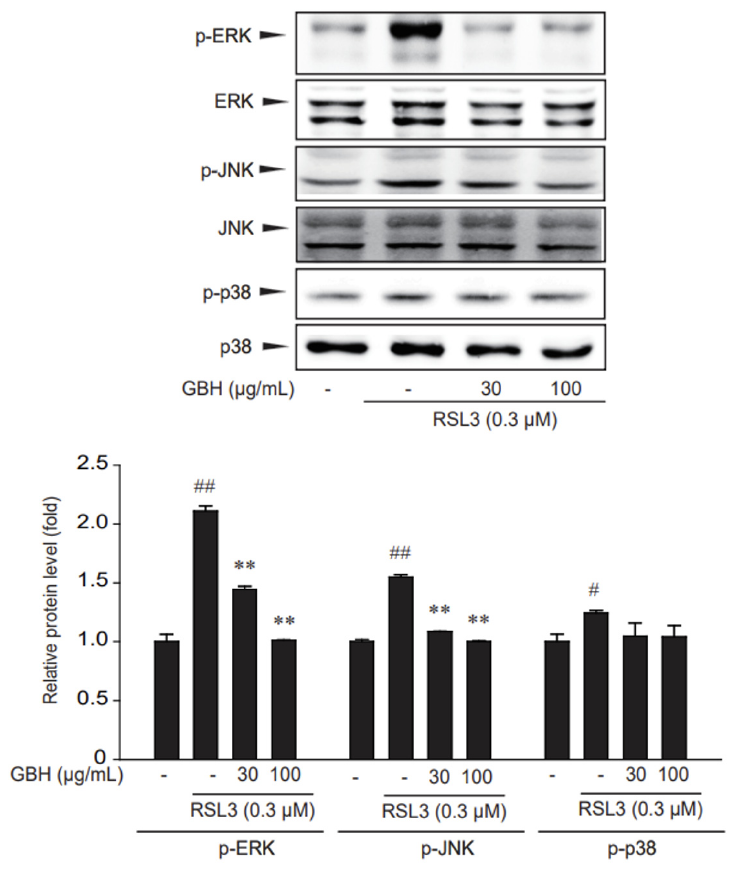
Figure 5. Inhibition of ERK and JNK phosphorylation by GBH in RSL3-induced HT22 cells. Im- munoblotting for MAPKs phosphorylation. Cells were treated with 30 or 100 µg/mL GBH 1 h before being incubated with RSL3 for 1 h. The cell lysates were immunoblotted. Data represent the mean ± S.E. of 3 experiments; ** p < 0.01, meaningful versus vehicle-treated control; # p < 0.05, ## p < 0.01, meaningful versus RSL3 alone.